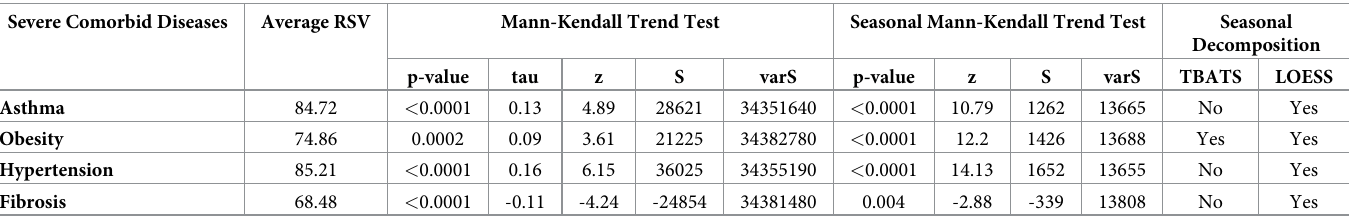
Table 4. Widespread weekly time series seasonal analysis of life style diseases (Jan 2004 to Dec 2016). (Complete raw data is given in S4 Table). Severe Comorbid Diseases Average RSV Mann-Kendall Trend Test Seasonal Mann-Kendall Trend Test Seasonal